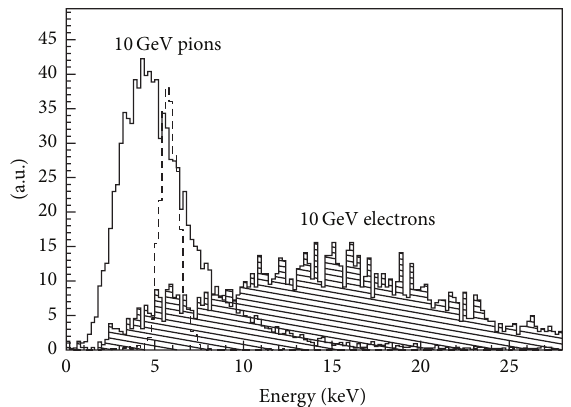
Figure 4: Energy deposited in the TRD straw tubes for pions and electrons (from [4,